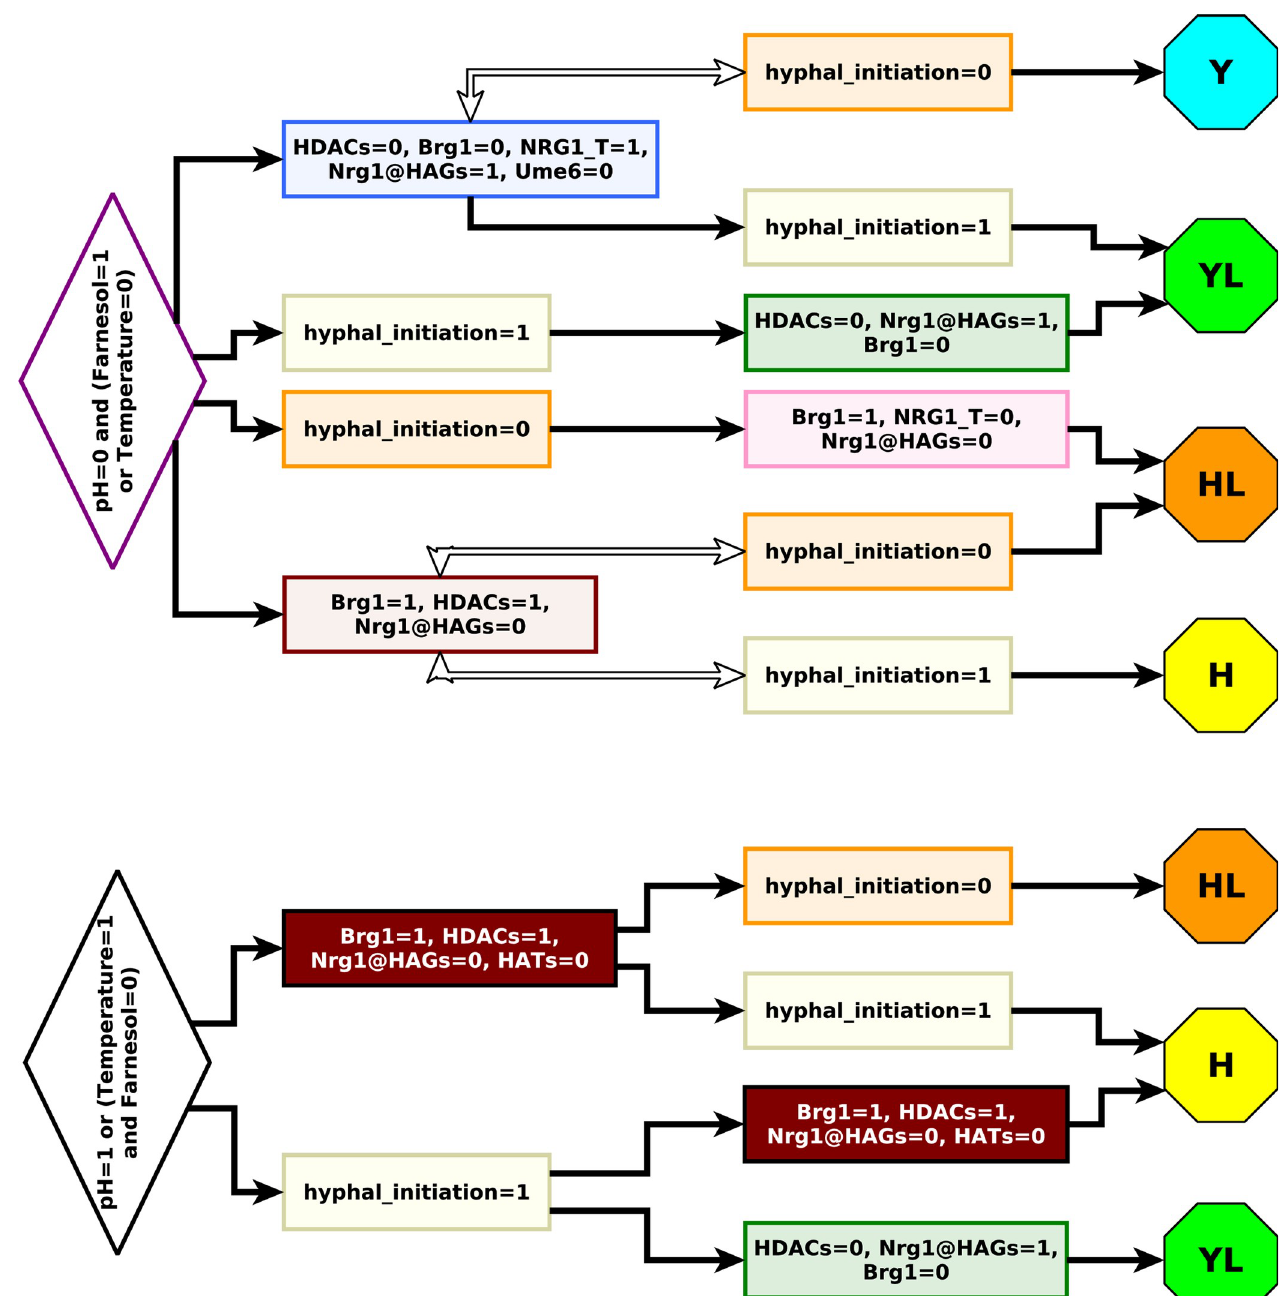
Fig 4. Stable motif succession. The YHT network stable motif succession shows paths to different phenotypes. The colored outlines identify each unique stable motif. From left to right, as subsets of the Boolean model satisfy the shown conditions, they become locked in as stable motifs. Bidirectional arrows indicate that either motif may lock in first. For an example trajectory, in YHT inducing conditions (bottom, such as pH = 1), if at any time Brg1 = HDACs = 1, while simultaneously Nrg1@HAGs = HATs = 0, then the dark brown conditionally stable motif becomes locked in. Further, once it is locked in, either of the conditionally stable motifs hyphal_initiation = 0, or hyphal_initiation = 1, may become locked in. Depending on which path is taken, the system will then evolve toward either the hyphal attractor (if hyphal_initiation = 1 locks in) or the hyphal-like attractor (if hyphal_initiation = 0 locks in).